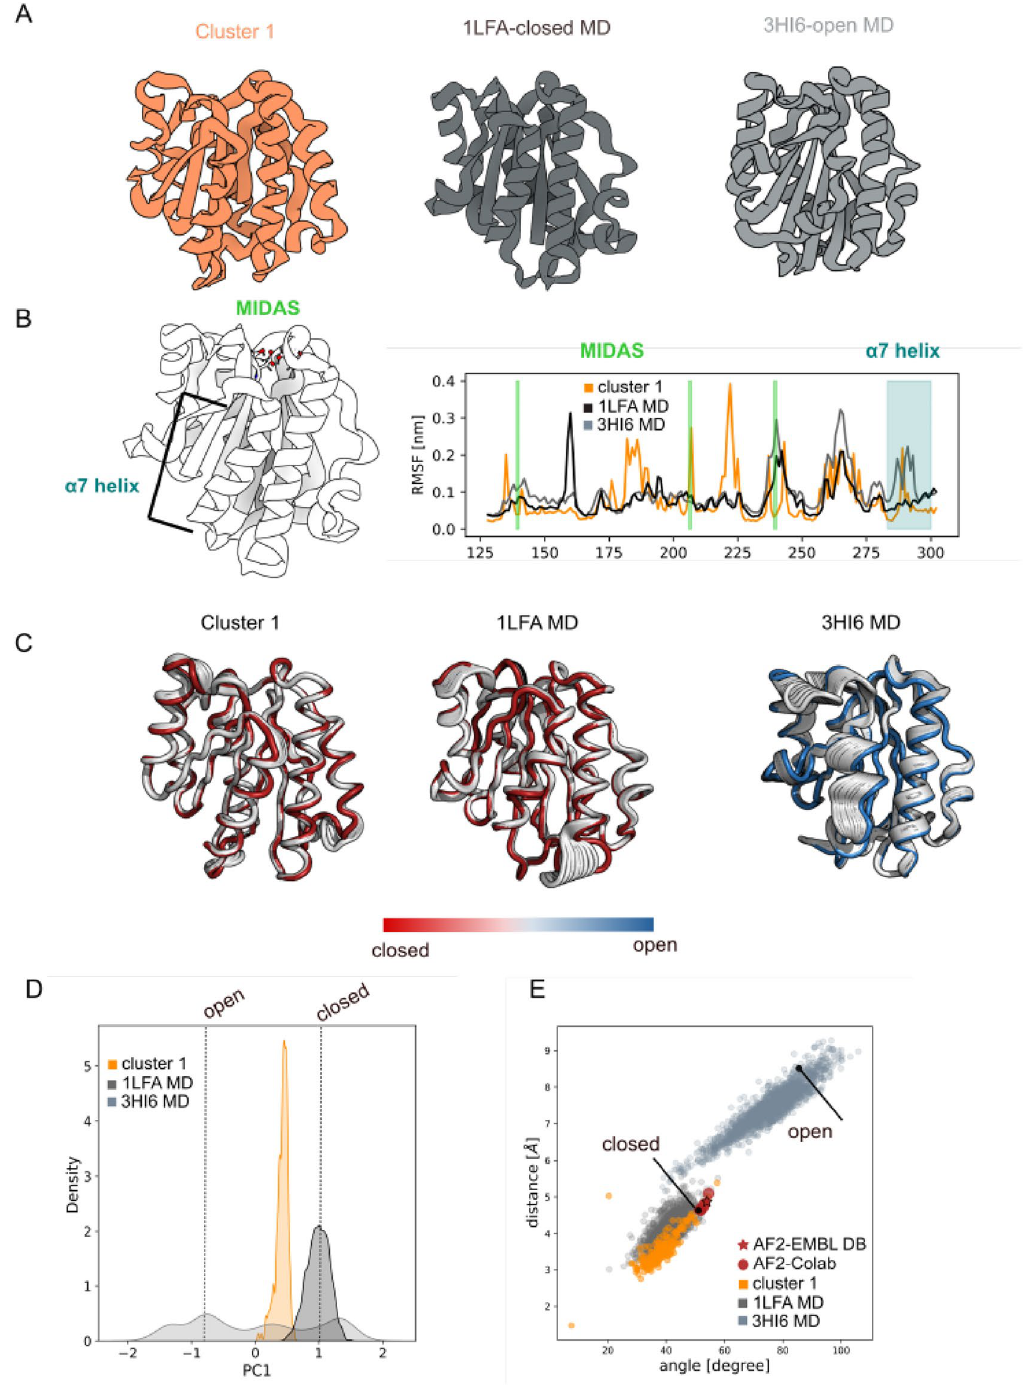
Figure 2. αI-domains of LFA-1. ( A ) Cartoon representation of the cluster centroid (orange), 1LFA-MD snapshot (dark-grey) and 3HI6-MD snapshot (light-gray); ( B ) Root Mean Square Fluctuation (RMSF) analysis showed the cluster rigidity α7-helix regions (orange) comparable to the closed 1LFA-MD conformation (dark-grey); ( C ) Principal Component Analysis for the cluster and MD simulations highlighted the protein internal movement showing the cluster low flexibility compatible with the 1LFA-MD simulation; ( D ) First component density distribution plot for 1LFA-MD (dark-grey), 3HI6-MD (light-gray) and cluster-1 (orange) unveiled that the cluster internal movement explored is compatible with the 1LFA-MD simulation; ( E ) distance/angle correlation analysis of cluster-1 (orange) overlaps with the conformational space explored by the 1LFA-MD closed conformations (dark-gray), while none of our predictions explored the open 3HI6 conformation. AlphaFold2 prediction from EMBLDB (red star) and Google Colab (red spheres) are also reported showing conformations near the closed X-ray structure. The closed and open X-ray αI-domains of LFA-1 conformations are specified with a black dot. The images were generated using 3D protein imaging webserver (https:// 3dpro teini maging. com/ prote in-